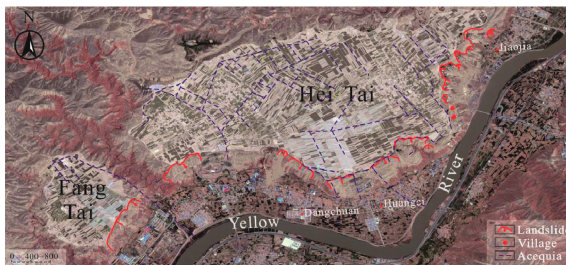
Figure 3: Distribution map of acequia and landslide in Heifangtai tableland of Gansu